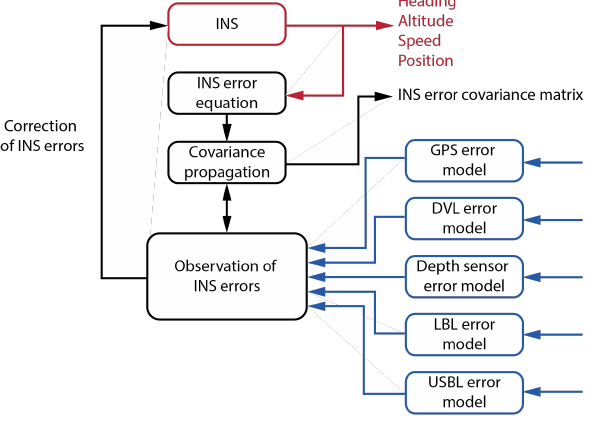
Figure 3. Function block diagram of the Kalman